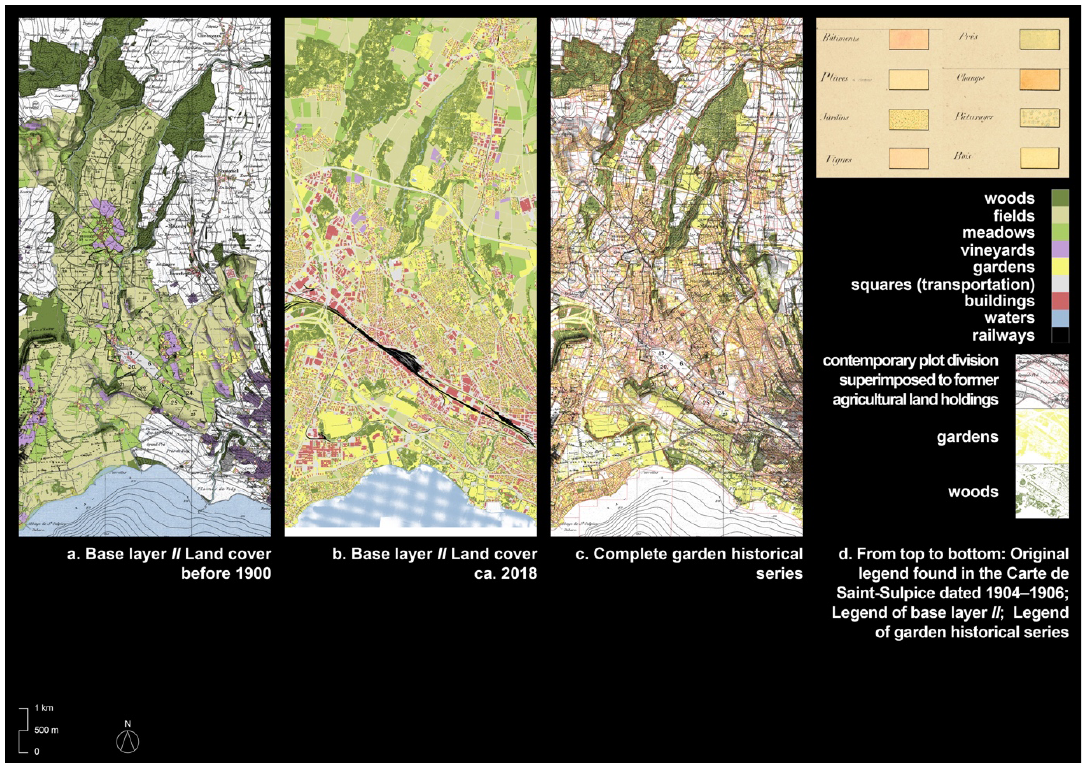
Figure 6. Base layer II. Source: Authors, based on geodata provided by Archives Cantonales Vaudoises, Canton de Vaud– Office de l’information sur le territoire, and Direction générale de l’agriculture, de la viticulture et des affaires